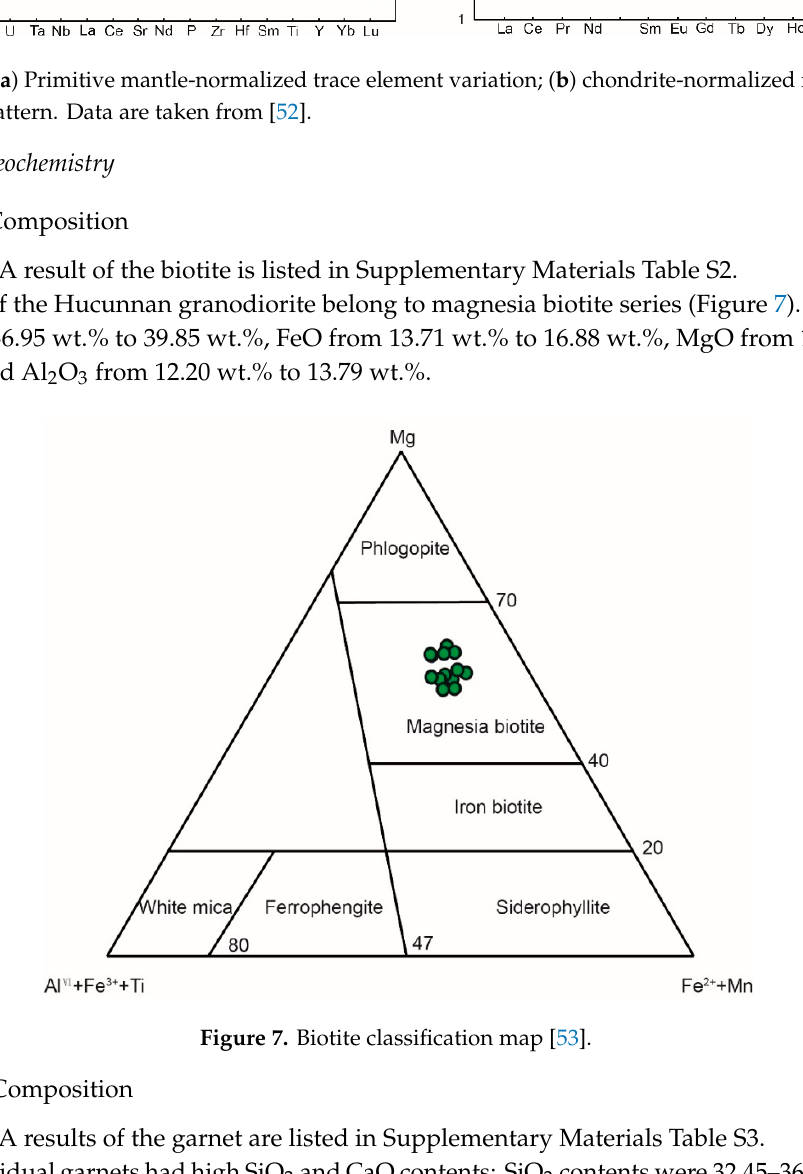
Figure 6. ( a ) Primitive mantle-normalized trace element variation; ( b ) chondrite-normalized rare earth element pattern. Data are taken from [52].